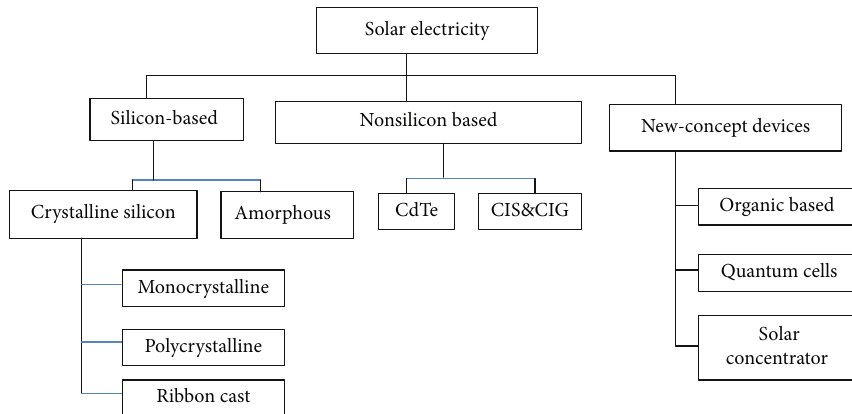
Figure 6: PV cell technology categorization [12, 23]. Table 1: E ffi ciency values of di ff erent PV modules. Type of PV